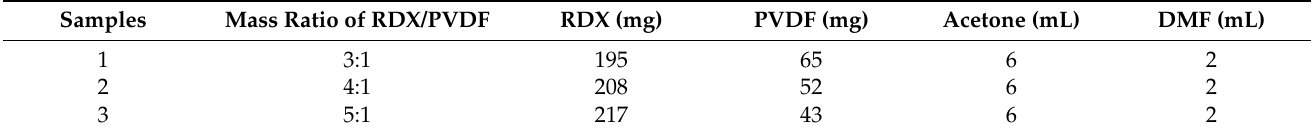
Table 1. The sample formulae of the RDX/PVDF precursor